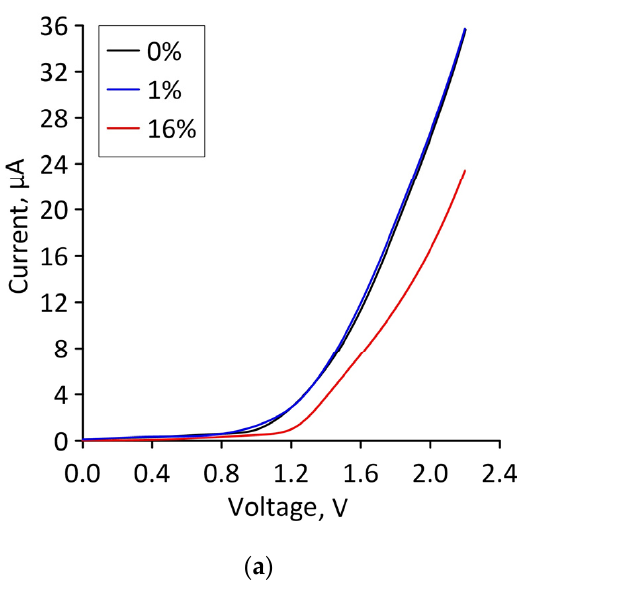
Figure 9. Current-voltage characteristics of bilayer graphene-SWCNT (12,6) hybrid films with island topology for various cases of axial compression: ( a ) model V1; ( b ) model V2.